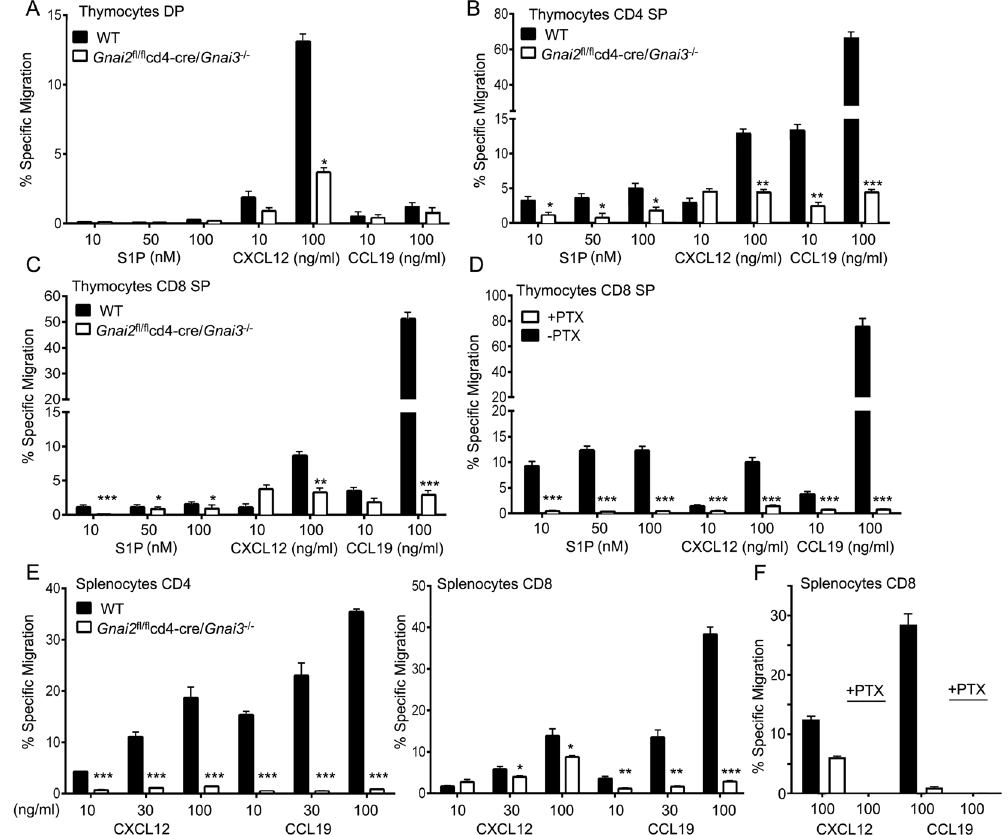
Figure 4. Analysis of migratory capacity of thymocytes and T cells from DKO mice. ( A–C ) Chemotaxis assays with increasing concentrations of S1P, CXCL12, and CCL19 as indicated. Shown are the percentages of DP ( A ), CD4 SP ( B ), and CD8 SP ( C ) thymocytes that specifically migrated. ( D ) Chemotaxis assays with increasing concentrations of S1P, CXCL12, and CCL19 as indicated. Shown are the percentage of CD8 SP thymocytes either pre-treated with pertussis toxin (PTX), or not, that specifically migrated. ( E ) Chemotaxis assays with increasing concentrations of CXCL12 or CCL19 as indicated. Shown are percentages of CD4, CD8, and PTX toxin treated CD8 cells that specifically migrated. Results are 4 mice of each genotype done in duplicate. * p < 0.05, ** p < 0.005 and *** p < 0.0005 (Student’s t